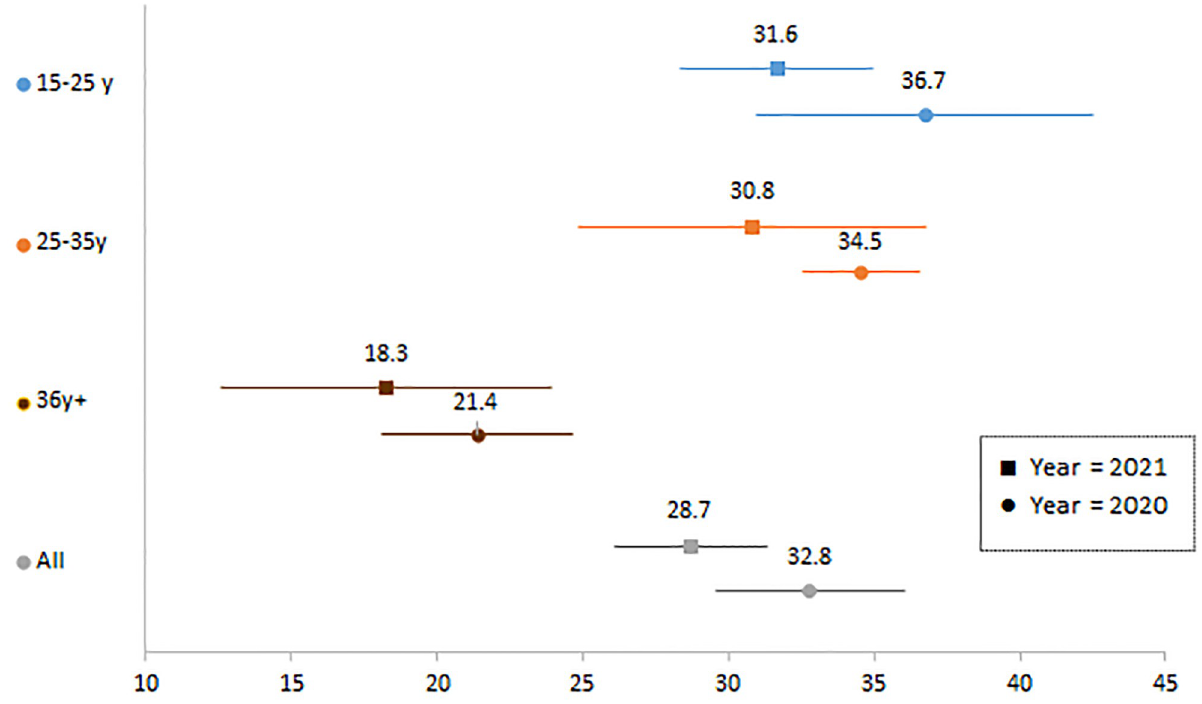
Fig 3. Desired lapse of time (in months) before next pregnancy in sexually active women in the four health districts under study, by year and age category. Estimates are derived from a mixed effects regression model, with random intercepts at the individual and district levels. The model is adjusted for the education level of the women and the socioeconomic status of the household. An interaction term between the year and the age category was forced in the model. Results are displayed in color according the age category: 16–25 years in blue, 26–35 years in orange, and 36 years and older in brown. Within each age category, the first (top) estimate represents the year 2020, while the 2021 estimate is displayed below. Estimates are presented with their 95% confidence interval.